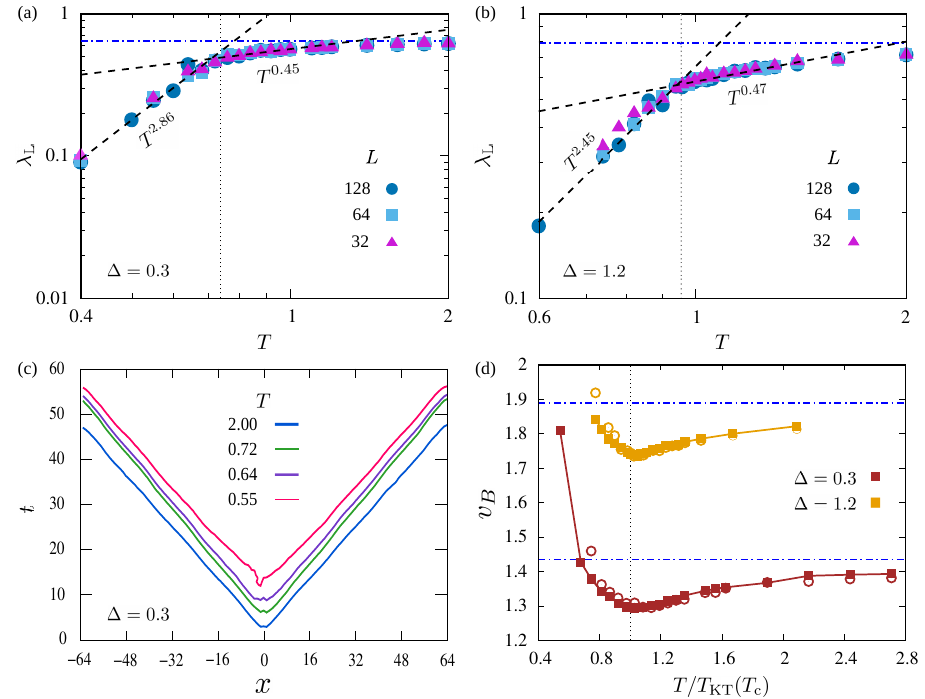
Figure 3: Temperature dependence of the Lyapunov exponent and the butterfly speed: (a) and (b) show the temperature dependence of λ across the KT and Ising L transitions for ∆ = 0.3 and ∆ = 1.2, respectively. Results are shown for three dif- ferent system size, L = 128 (circle), 64 (square) and 32 (triangle). Power law fits ( T ) and T > T ( T ) (dashed lines). The dashed- have been obtained for T < T KT c KT c dotted line represents the value of λ at infinite temperature. (c) Ballistic light cones L ( x , t ) = 0) at different temperature across the KT transition. The butterfly speed, ( λ L v , and the delay time, t , are found from a linear fit to the light cones. (d) Temper- B 0 ature dependence of butterfly speed for easy-plane and easy-axis anisotropies across KT and Ising transitions, respectively, for L = 128 (square) and 64 (open circle). The dashed-dotted line denotes the value of v at infinite temperature. Minima are B observed at the transitions (vertical dotted